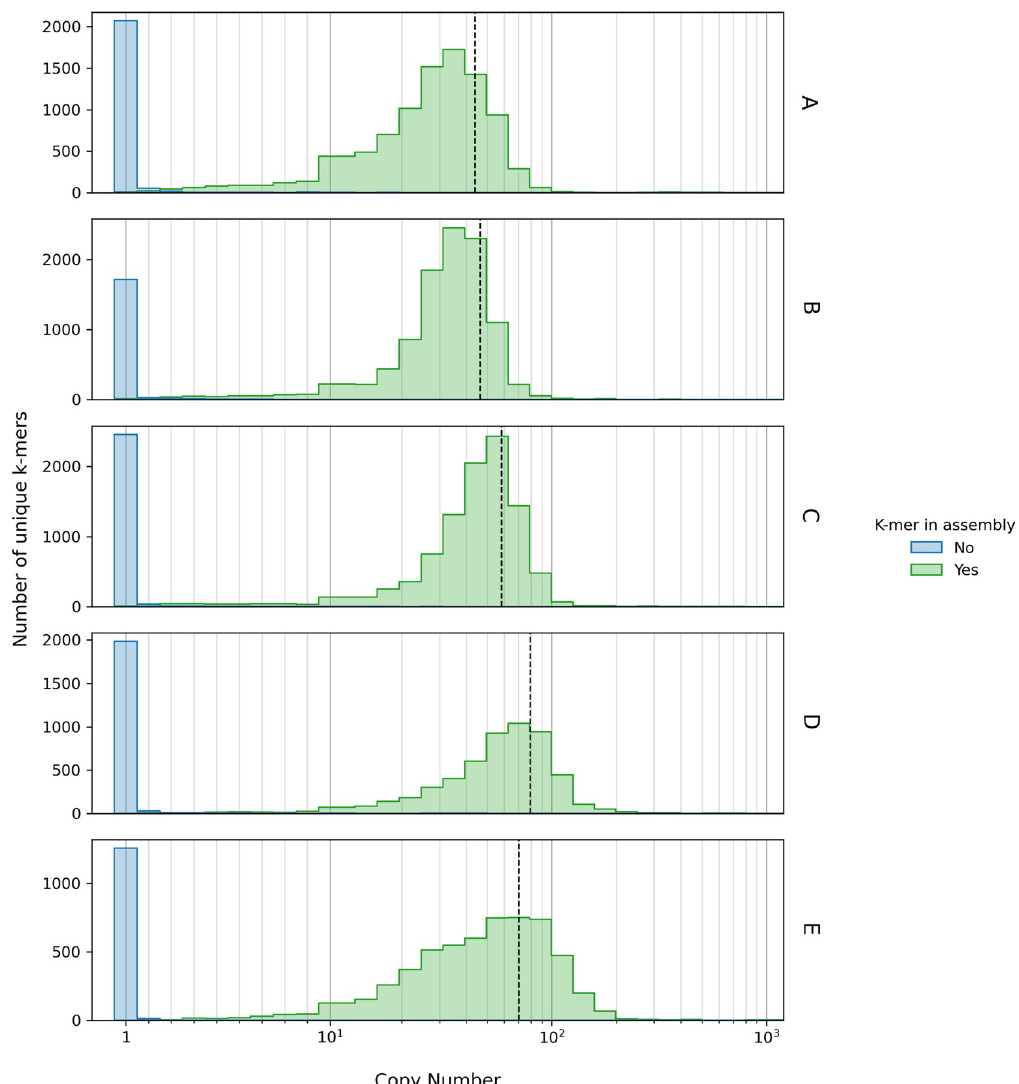
Fig 3. Distribution of k-mer counts in raw sequencing reads. Raw FASTQ files for a selection of Set 3 genomes were scanned for k-mer matches using the standard GAMBIT procedure. After discarding matches containing nucleotides with PHRED scores less than 20 the number of copies of each unique k-mer found was tallied. Species were P . stuartii , E . coli , Y . enterocoliticia , E . faecalis and S . epidermis for subplots A-E, respectively. The blue histograms show the copy number of k-mers found in the raw sequencing reads that are not recovered after assembly, and likely represent sequencing errors. The green histograms show the copy number of k-mers found in the sequencing reads that are present in the final genome assembly. The center of these distributions closely tracks the sequencing depth (denoted by the black dashed vertical line). Note that histogram bins encompass single integers from 1–10 and are thereafter logrithmically